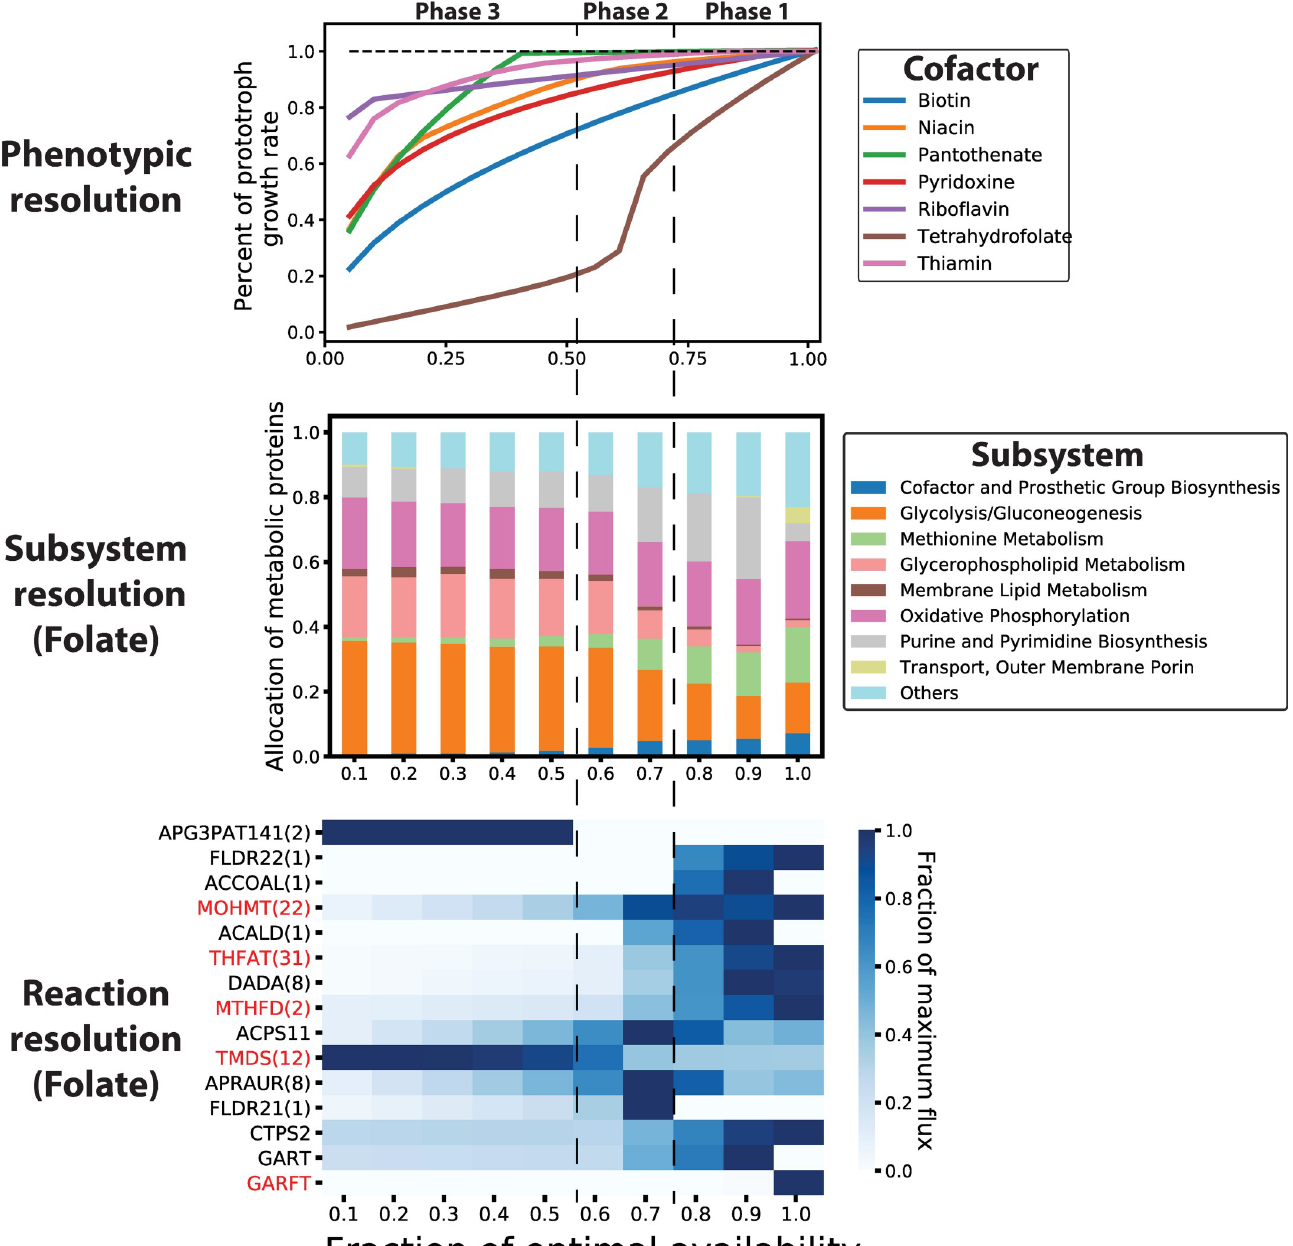
Fig 6. Computed growth rate in auxotrophic models of i JL1678b when the availability of the essential cofactor in the legend is limited. For each of the 7 metabolites shown in the legend, reactions were imposed into the model creating an auxotrophy for that metabolite ( Table C in S1 Text ). Top panel : The growth rate is plotted as a function of the availability of the metabolite indicated in the legend. The percent change in the growth rate compared to the wild-type (prototroph) model is shown. Middle panel: Model-predicted metabolic changes in response to tetrahydrofolate limitation. The mass fraction of protein allocated to each metabolic subsystem during tetrahydrofolate limitation is shown (columns) Bottom pane l: Heatmap showing fraction of maximum growth rate- normalized reaction fluxes. The 15 reactions with the highest standard deviation are shown and are highlighted in red if the reaction relies on folate activity. If reaction fluxes were perfectly correlated throughout the tetrahydrofolate limitation simulations, then these reactions were grouped together. The number in parentheses shows the number of other reactions represented by the row. The right column depicts a simulation with the highest folate availability and the left column depicts a simulation with the lowest folate